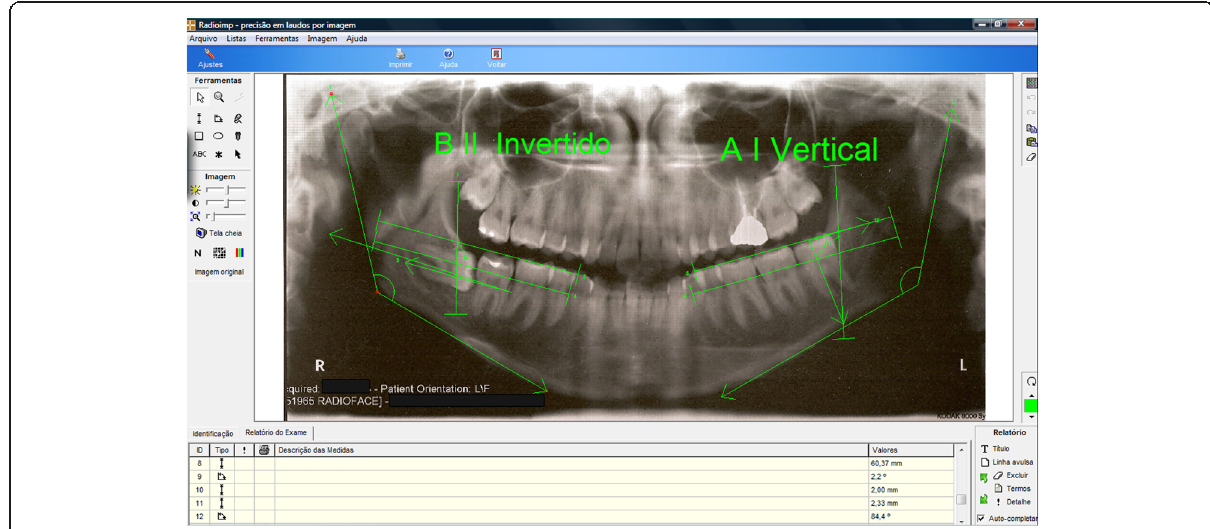
Fig. 3 Radioimp® software used to obtain the M3 classification and dental follicle